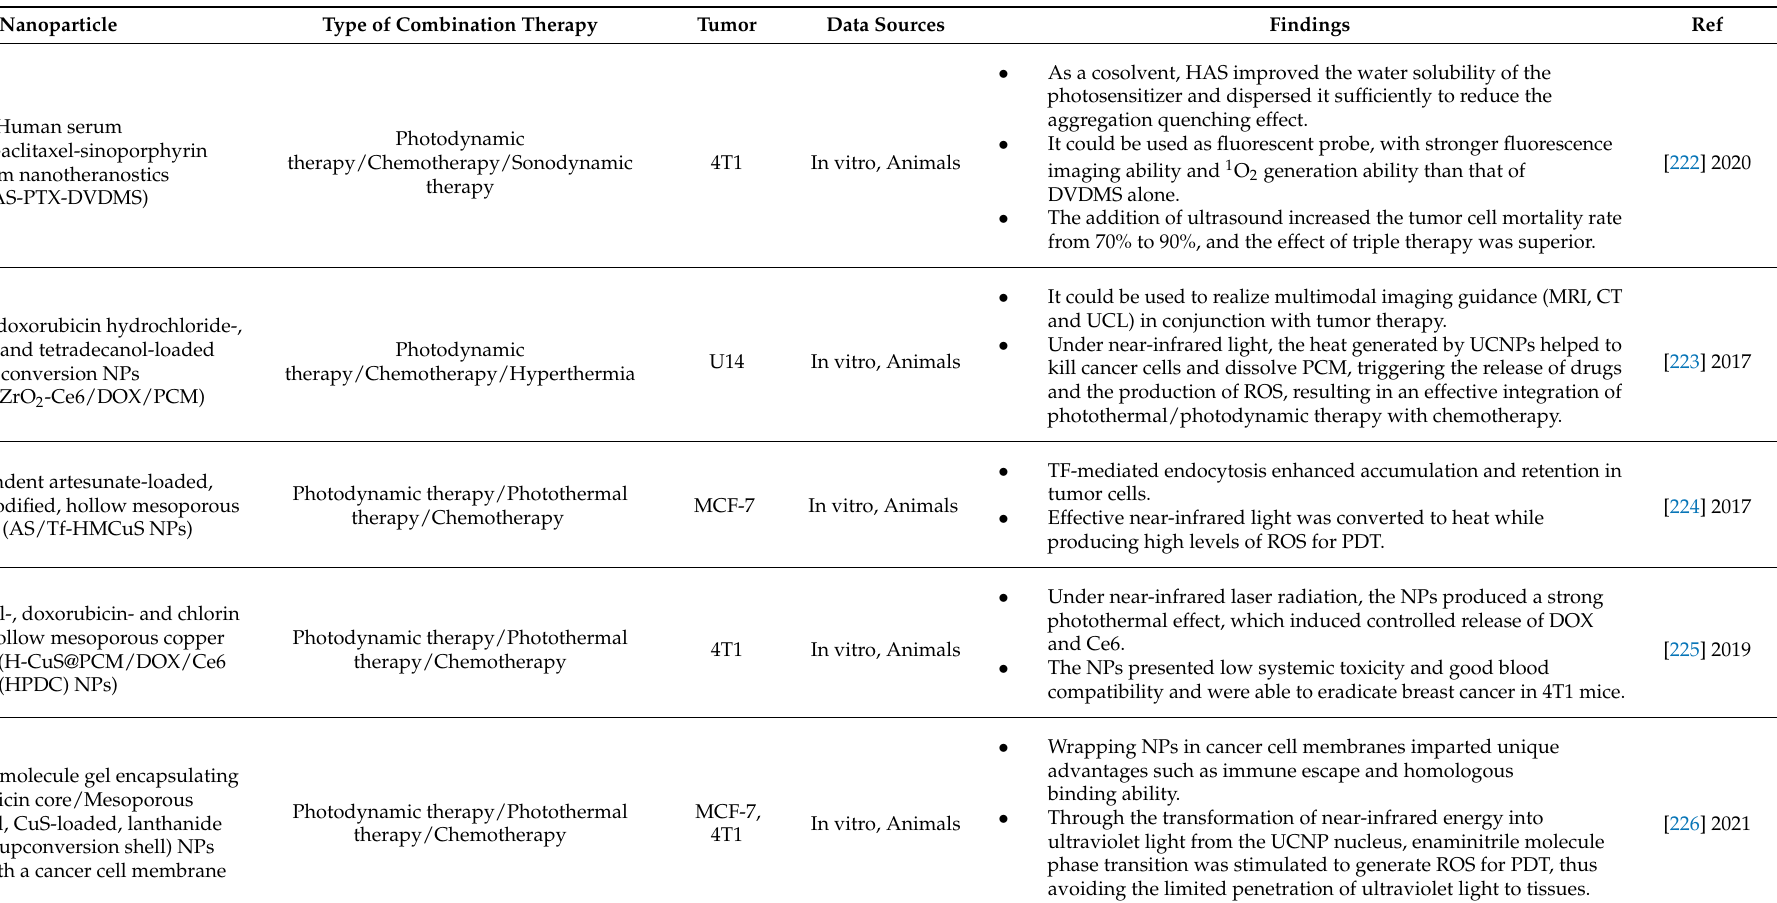
Table 8. Codelivery of multidrugs based on